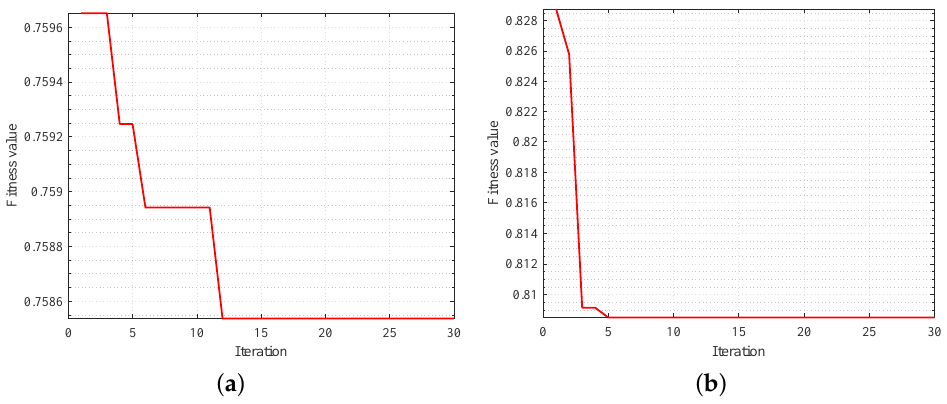
Figure 13. Convergence curve of WOA-VMD-BD fitness function of simulated data. ( a ) HH polariza- tion mode. ( b ) HV polarization mode.